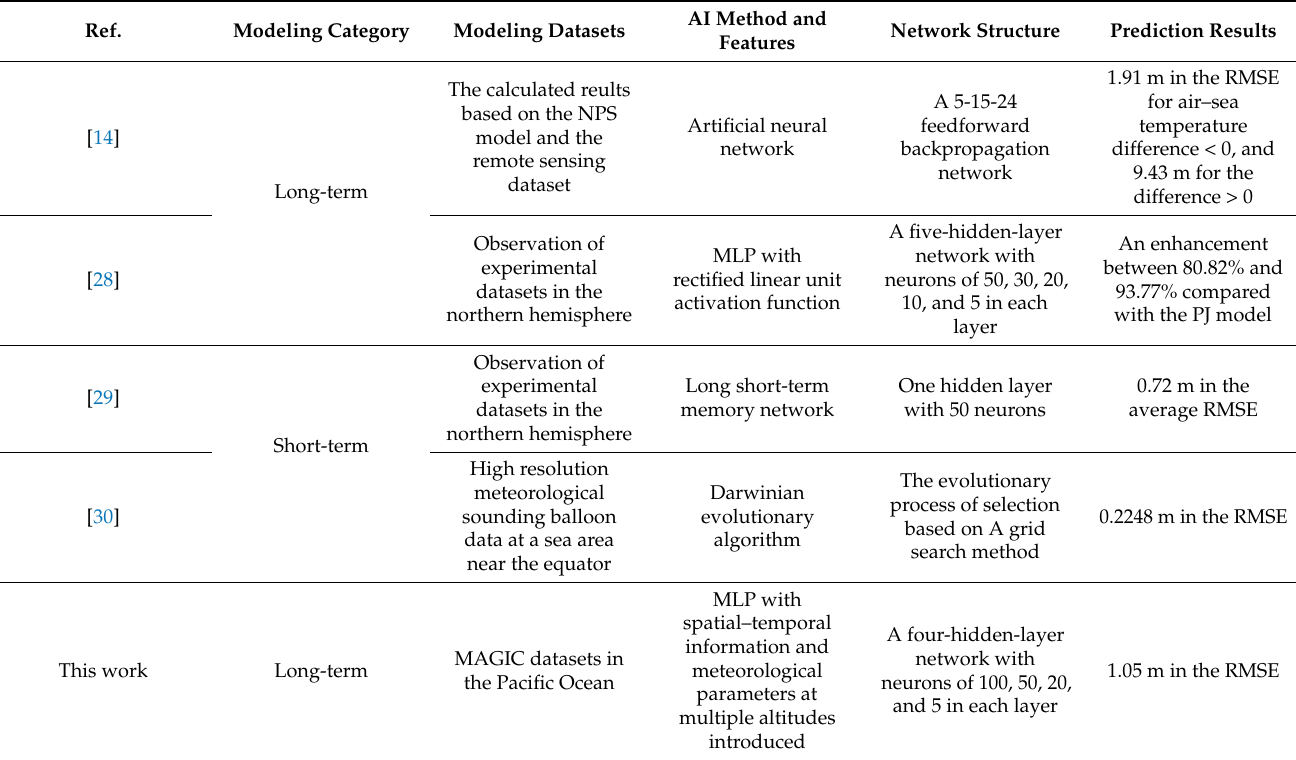
Table 7. Comparison of different models in EDH